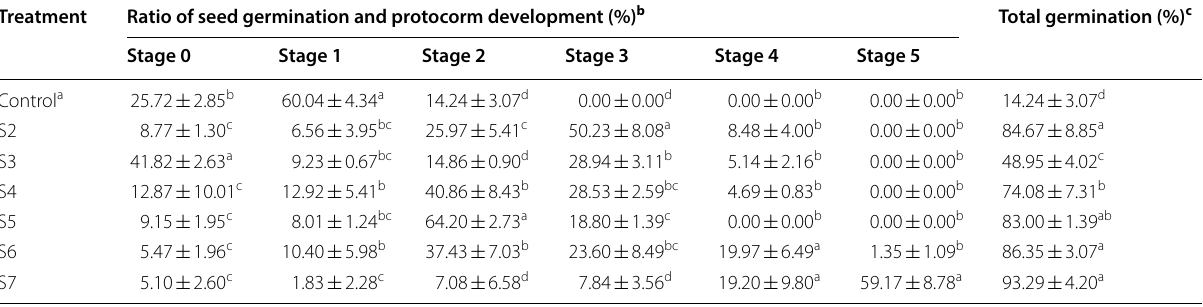
a Control, the seeds without fungal inoculation b c Germination was defined as emergence of the embryo from the seed coat (stage 2)